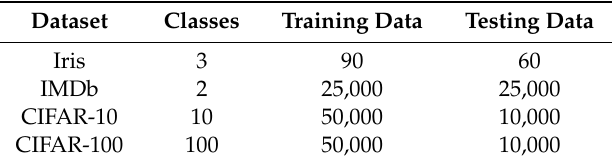
Table 1. Datasets used in this paper.